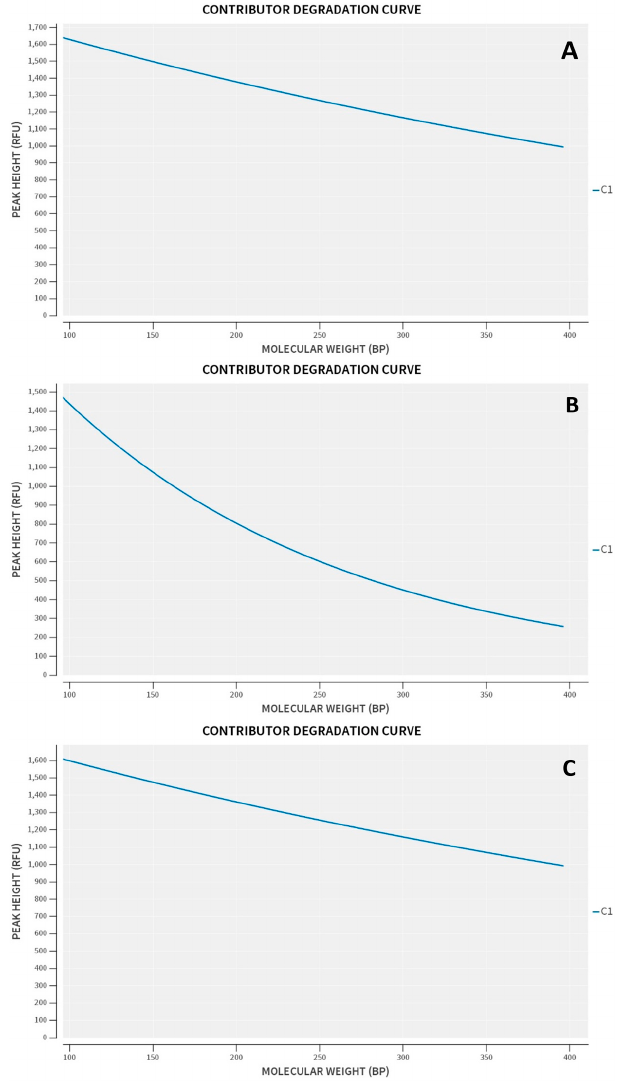
Figure 9. DSCS (3 cell subsample, S3-5C-1) degradation curves. Regular sample ( A ), Degraded sample ( B ), Inhibited sample ( C ).